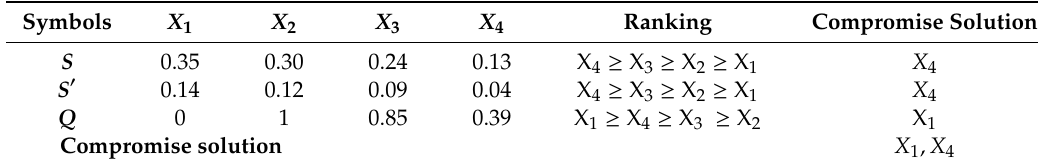
Table 5. Ranking results.